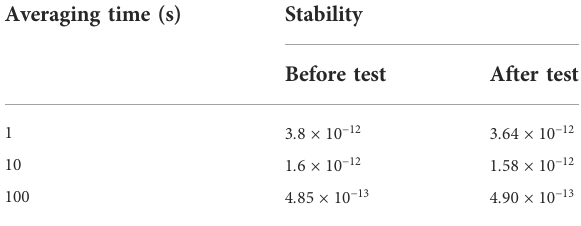
TABLE 2 Frequency stability before and after the random vibration test. Averaging time (s)